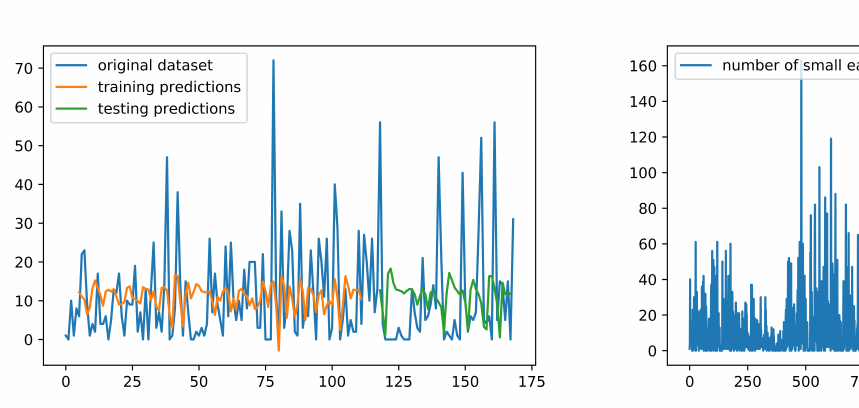
Figure 6. Time series of number of small earthquakes between two subsequent large earthquakes in Experiment 4